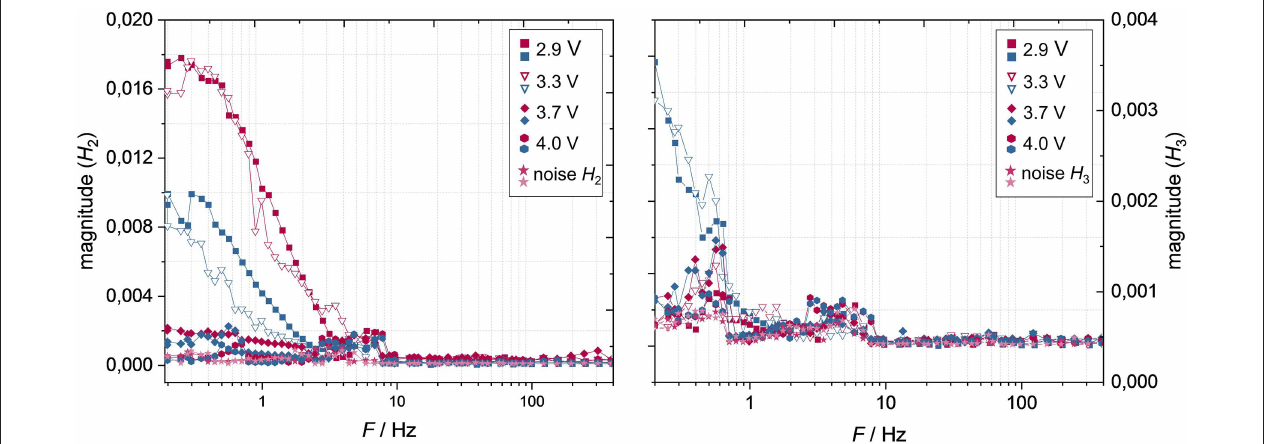
FIGURE 7 | NLEIS cell spectra of the 2nd harmonic (Left) and 3rd harmonic (Right) for charge (red) and discharge (blue) direction as a function of cell voltage and at a temperature of 20 ◦ C with the corresponding random noises.